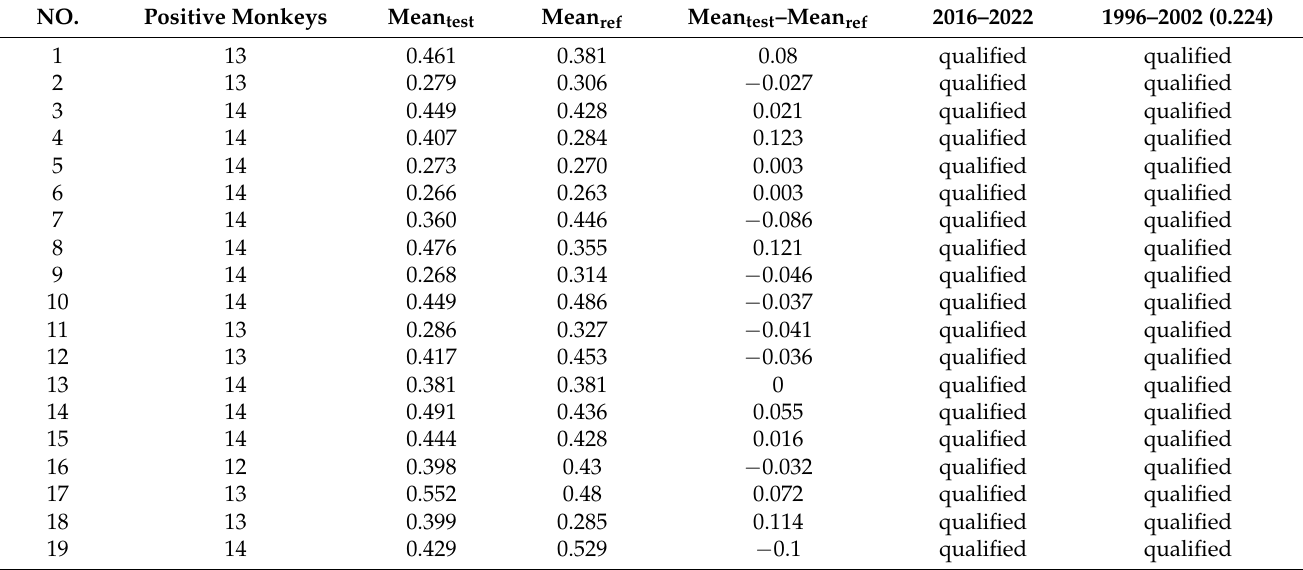
Table 5. The mean value of type I OPV stock solution between 2016 and 2022 and the MNVT qualification under different judgment